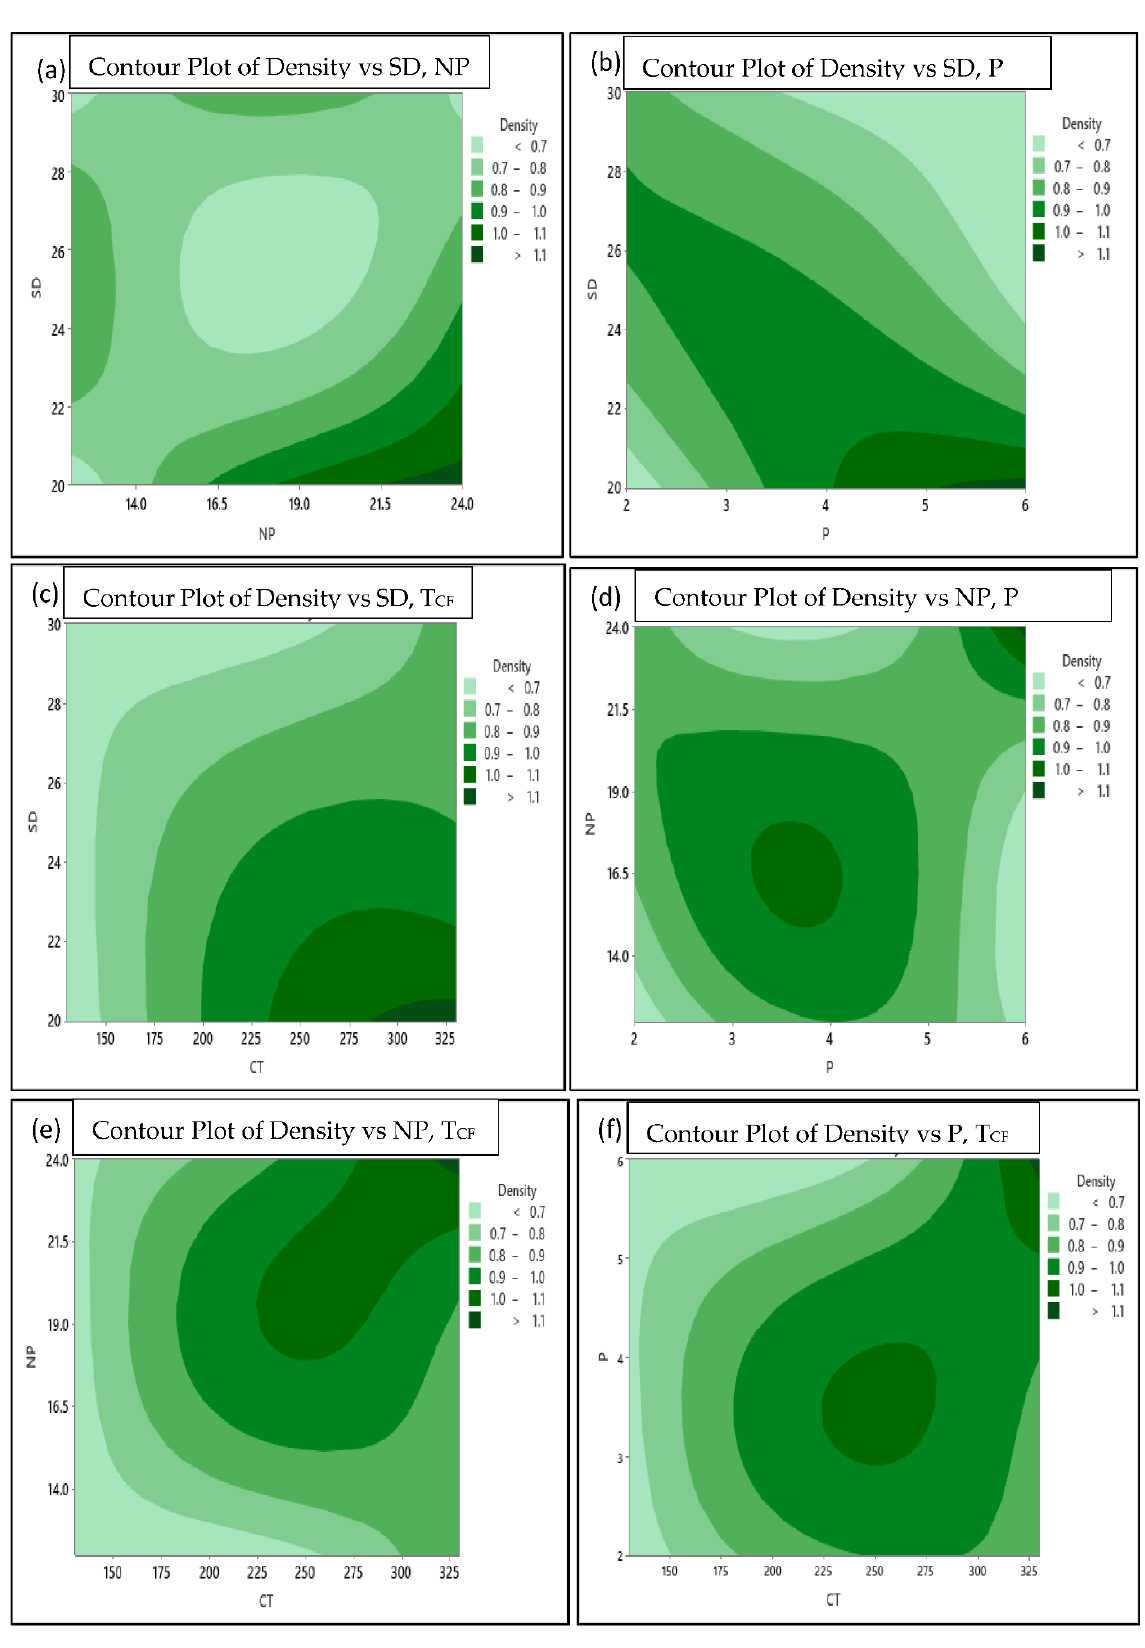
Figure 5. Contour plot for C d vs. ( a ) SD and NP, ( b ) SD and P, ( c ) SD and T CF , ( d ) NP and P, ( e ) Np and T CF and ( f ) P and T CF .